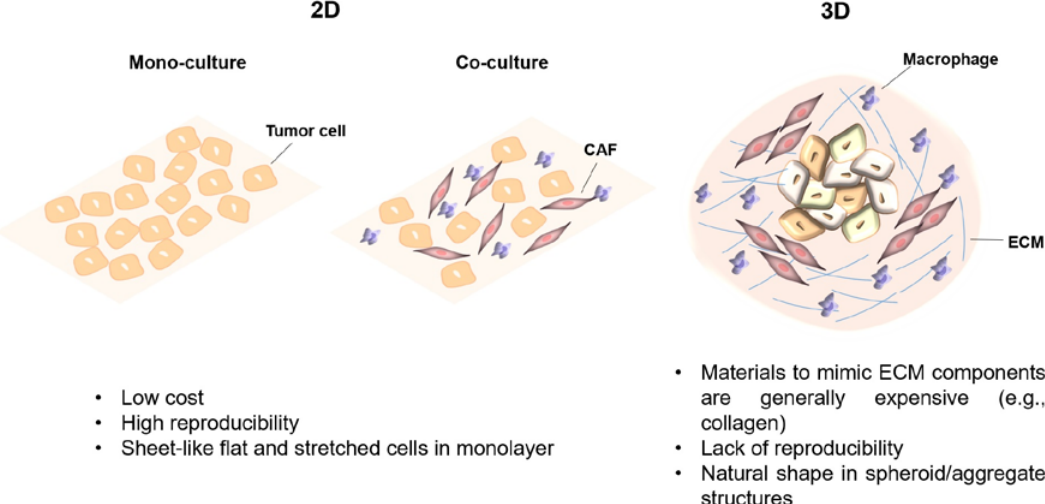
Figure 4. Main properties of in vitro 2D and 3D culture systems [187,188]. CAF, Cancer-associated fibroblast; ECM, Extracellular matrix.